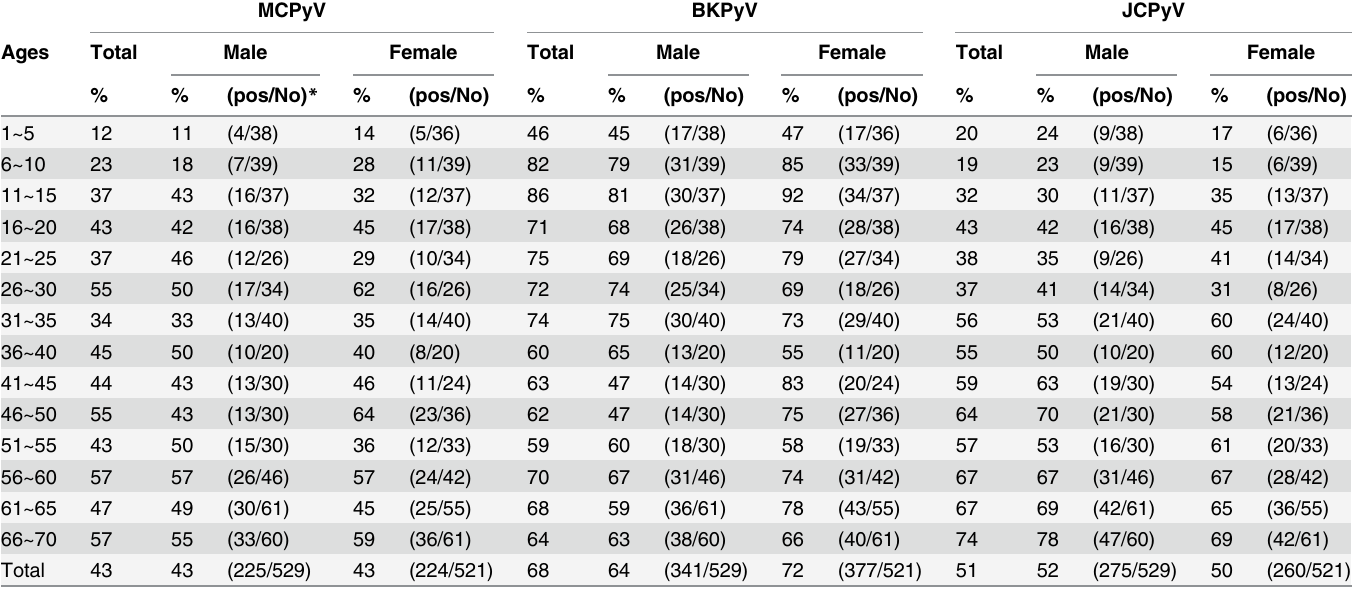
Table 1. Seropositivity of IgG antibodies against MCPyV, BKPyV and JCPyV in the general Japanese population aged 1 – 70